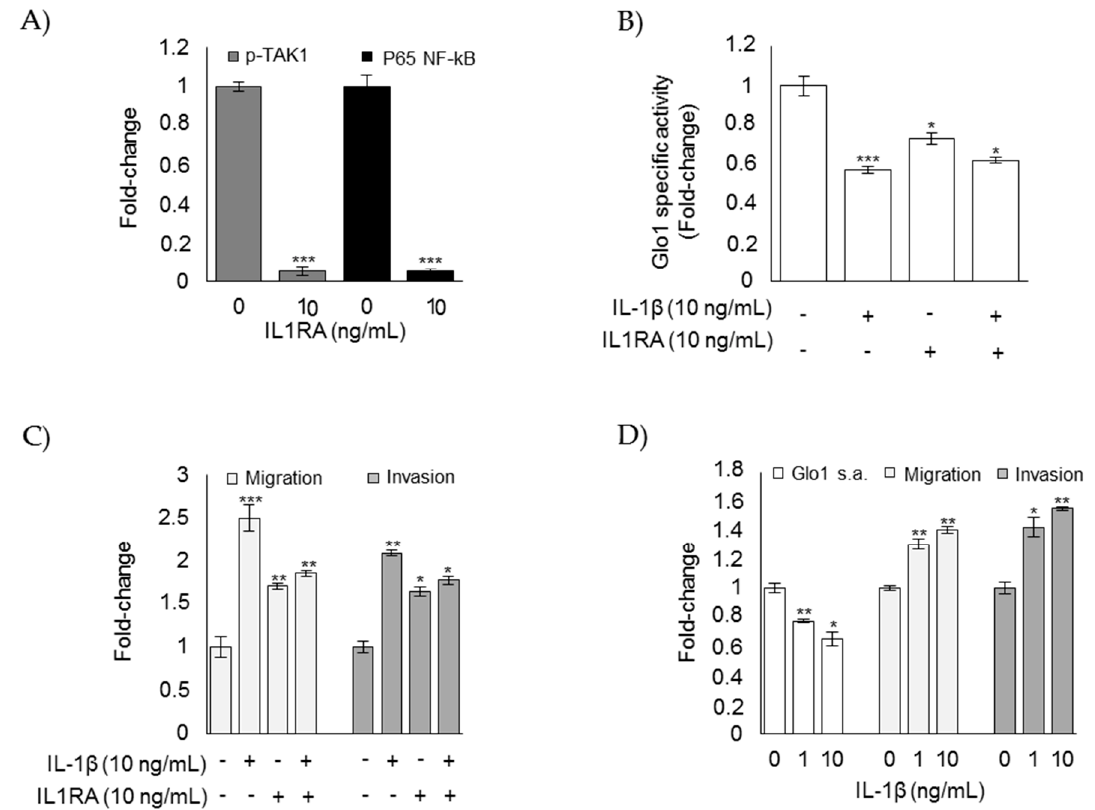
Figure 10. The effect of a specific IL-1 receptor antagonist (IL1RA) administrated to CAL65 anaplastic thyroid cancer cells for 3 h alone ( A ) or in combination with IL-1 β ( B,C ) on ( A ) phospho-TAK1 (p-TAK1) (measured in the cell lysates) and P65 NF-kB (measured in the nuclear extracts) by ELISA; ( B ) Glyoxalase 1 (Glo1)-specific activity, measured by a spectrophotometric assay; and ( C ) migration and invasion capabilities, evaluated by specific assays. ( D ) Effect of the long-term exposure (2 weeks) of TPC1 papillary thyroid cancer cells to IL-1 β on Glo1 specific activity (s.a.), migration, and invasion. Histograms indicate mean ± SD of three different cultures each tested in triplicate. * p < 0.05, ** p < 0.01, and *** p < 0.001 compared to untreated cells.